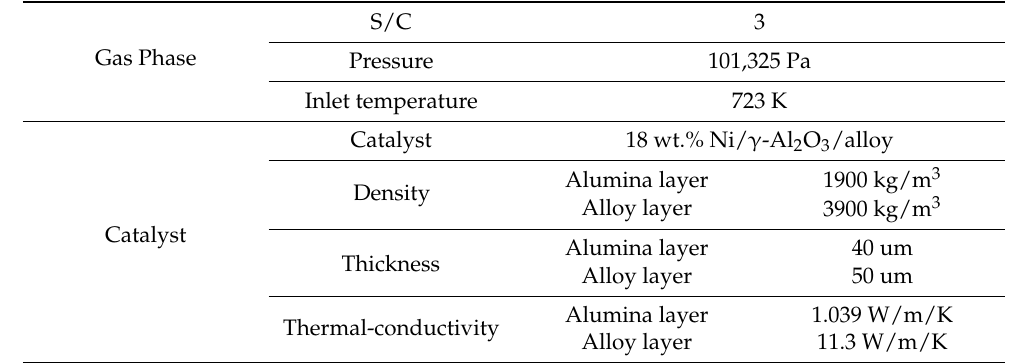
Table 1. Reaction conditions and catalyst parameters.